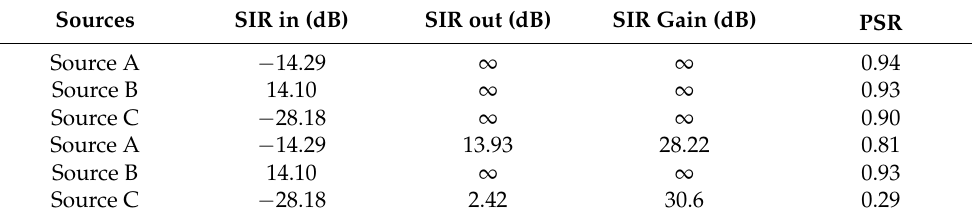
Figure 11. Three sources, the mixture and three de-mixed signals. Table 6. Comparison of the de-mixing performance in Experiment 3 (top) with that of the conventional T-F mask approach